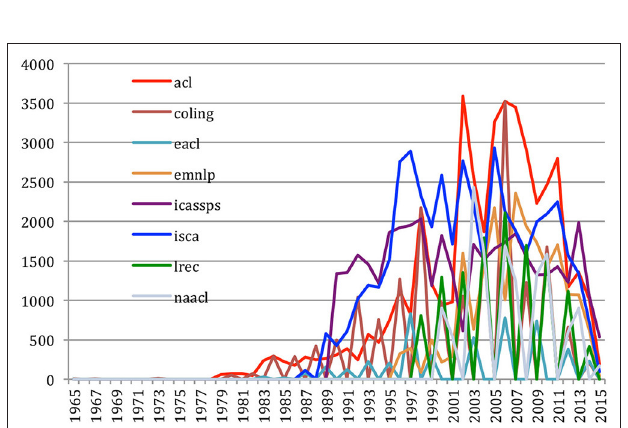
FIGURE 42 | (A) Authors’ citation graph. (B) Papers’ citation